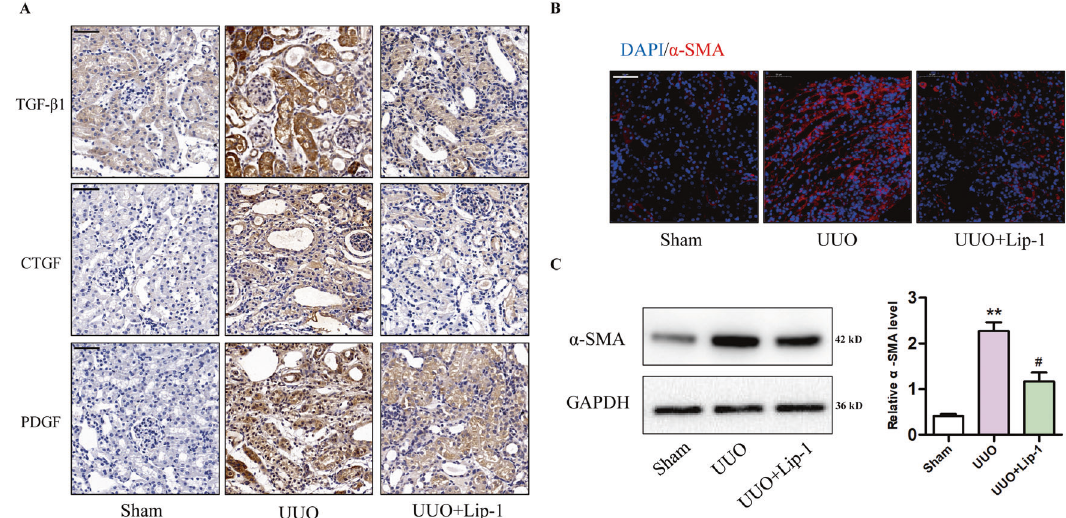
Fig. 4 Effects of Liproxstatin-1 on pro fi brotic factor secretion and myo fi broblast activation in the UUO model. A Immunohistochemical staining of TGF- β 1, CTGF, and PDGF (bar = 50 μ m). B Immuno fl uorescent analysis with nuclear stained with DAPI (blue), ɑ -SMA (red) in kidney tissue sections (bar = 50 μ m). C Protein expression of ɑ -SMA in renal tissues of mice detected by western blotting ( n = 3, ** P < 0.01 vs sham group; # P < 0.05 vs UUO group). The data are presented as the mean ±